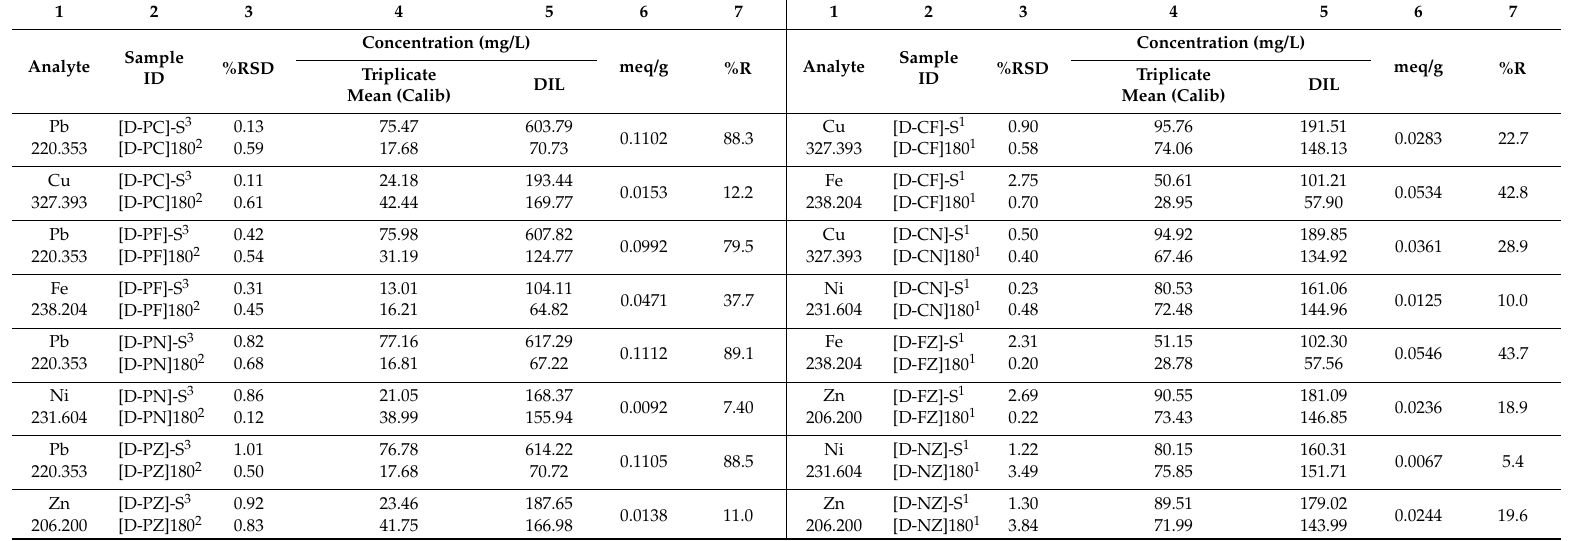
Table 2. ICP-AES HMI results of the dual-component